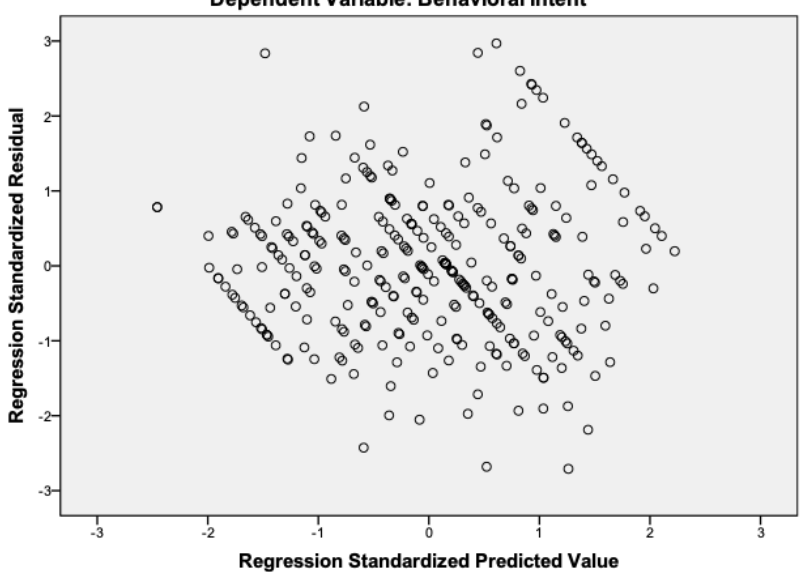
Figure 2. Scatterplot of the standardized residuals against predicted values.